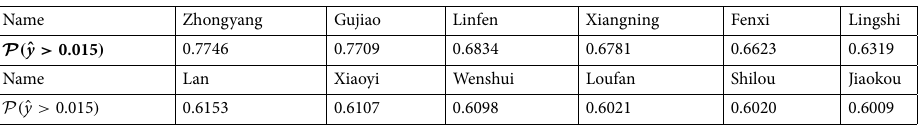
Table 3. Table of lower administrative regions predicted to be at high risk of collapsibility. ˆ y refers to the estimated collapsibility